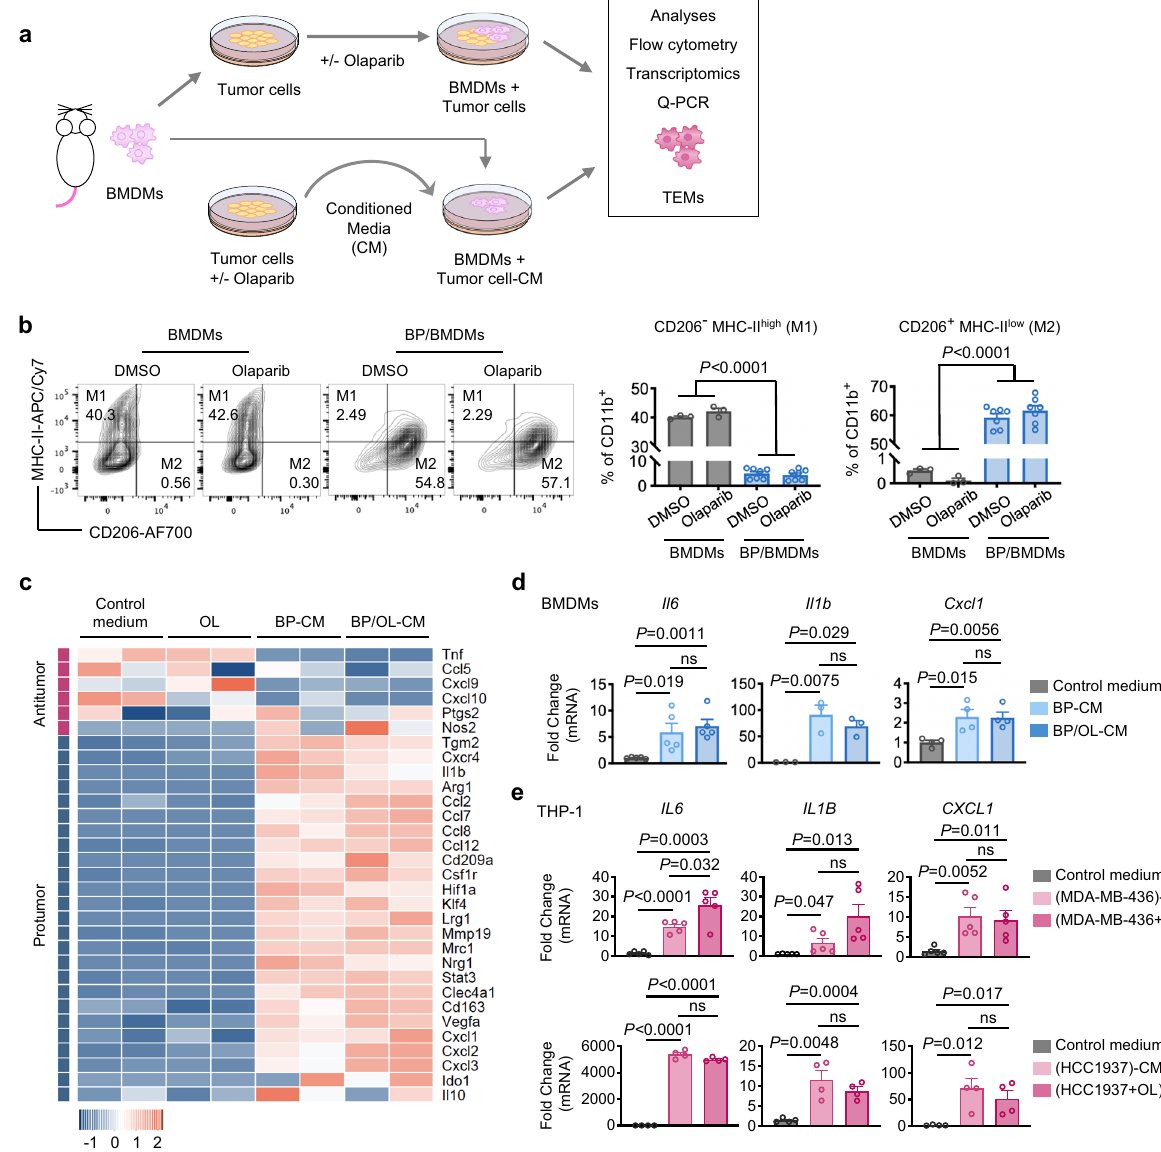
Fig. 2 BRCA1-de fi cient breast tumor cells induce M2-like macrophage polarization in vitro. a Diagram of work fl ow. Top, mouse bone marrow-derived macrophages (BMDMs) co-cultured with tumor cells with or without olaparib treatment. Bottom, BMDMs were incubated with 50% conditioned media (CM) harvested from olaparib- or DMSO-treated tumor cells. TEMs, tumor cell-educated macrophages. b Flow cytometry analysis of BMDMs co-cultured with BP tumor cells with or without olaparib (5 μ M) for 2 days. BMDMs (CD11b + ) were plotted as CD206 versus MHC-II to identify M1-like (CD206 - MHC-II high ) and M2-like (CD206 + MHC-II low ) polarization phenotypes (BMDMs, n = 3; BP/BMDMs, n = 7). Flow cytometry plot axes are displayed in logarithmic scale. c Heat map of gene expression for anti-tumor and pro-tumor genes in BMDMs incubated with DMSO vehicle control, olaparib (OL, 5 μ M), 50% BP-CM, or 50% OL-treated BP (BP/OL)-CM for 24 h ( n = 2 for each group). d RT-qPCR analysis of mouse BMDMs incubated with control medium, 50% BP-CM, or 50% BP/OL-CM for 24 h ( Il6 , n = 5; Il1b , n = 3; Cxcl1 , n = 4). e RT-qPCR analysis of THP-1 human macrophages incubated with control medium, 50% tumor cell-CM, or 50% CM of olaparib-treated tumor cells for 24 h (MDA-MB-436, n = 5; HCC1937, n = 4). Data are presented as mean ± SEM. One-way ANOVA ( b ). Two-tailed unpaired t test or Mann – Whitney test ( d ) and ( e ). ns, not signi fi cant. Source data are provided as a Source Data fi mutant breast cancer cell lines MDA-MB-436 or HCC1937. immunosuppressive function of TEMs, we generated TEMs by Consistently, THP-1 macrophages treated with CM of tumor cells incubating BMDMs with BP-CM for 2 days, followed by co- or CM of olaparib-treated tumor cells showed signi fi cantly up- culturing with splenic CD8 + T cells isolated from naïve mice. Our results showed that TEMs, but not control BMDMs, signi fi cantly regulated IL6 , IL1B and CXCL1 gene expression (Fig. 2e). These reduced IFN γ , TNF α and Granzyme B production by CD8 + data suggest that BRCA1 -de fi cient breast tumor cells can “ educate ” macrophages to become M2-like pro-tumorigenic T cells, suggesting that BP TEMs acquire an immunosuppressive function (Supplementary Fig. 2k). macrophages independent of PARPi. To assess the